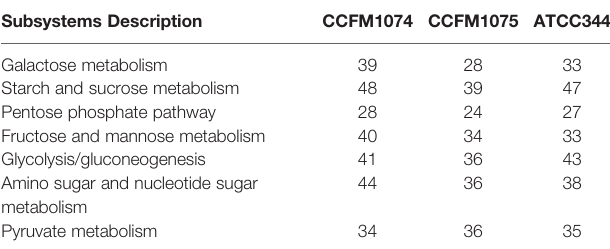
TABLE 1 | Genes number of carbohydrate metabolism